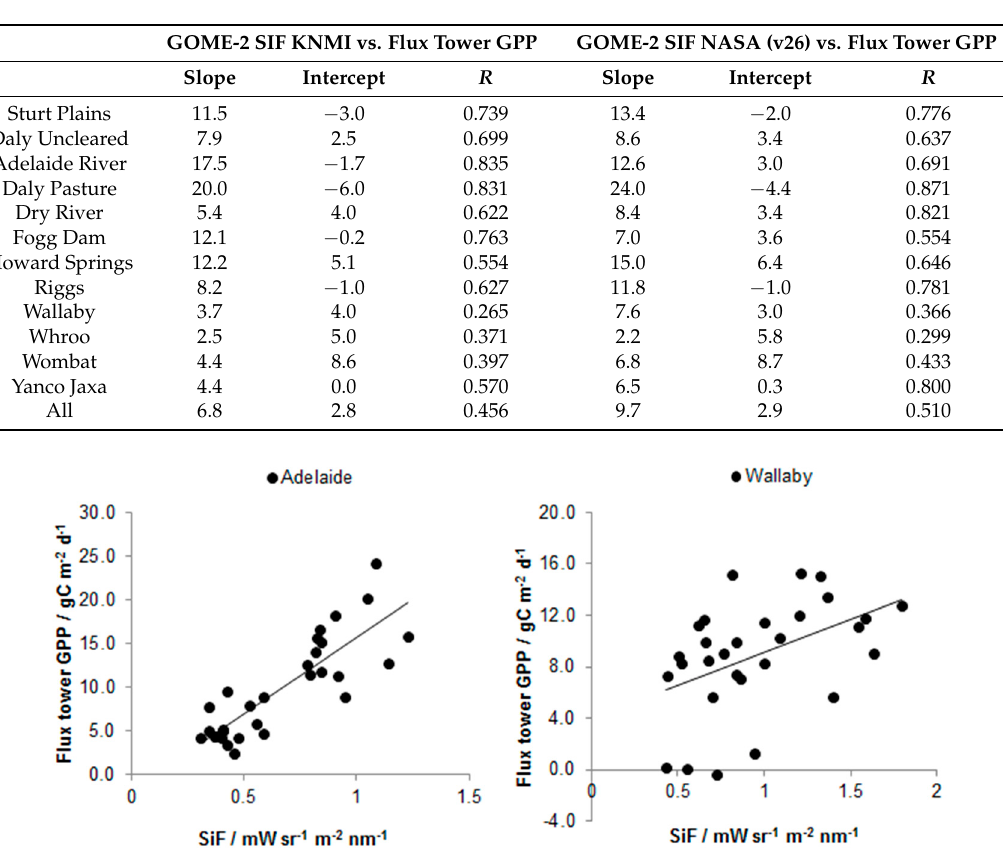
Table 2. Comparison of Sun-induced Fluorescence (SiF) time series from KNMI and NASA (v26) with Gross Primary Productivity (GPP) derived from Australian flux tower sites for the period January 2007 to June 2015. For each site the slope, intercept and correlation between the time series are given: the linear relation reads as GPP = intercept + slope × SiF.